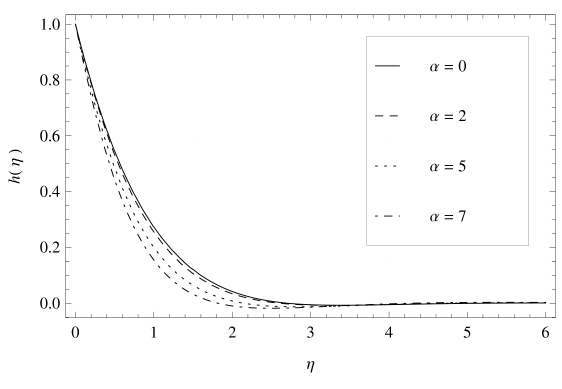
Fig. 13: The influence of a parameter We on k ( η ) for λ = 0.1, α = 3, M = 0.4, f = 0.9, (cid:126) = −0.01 w